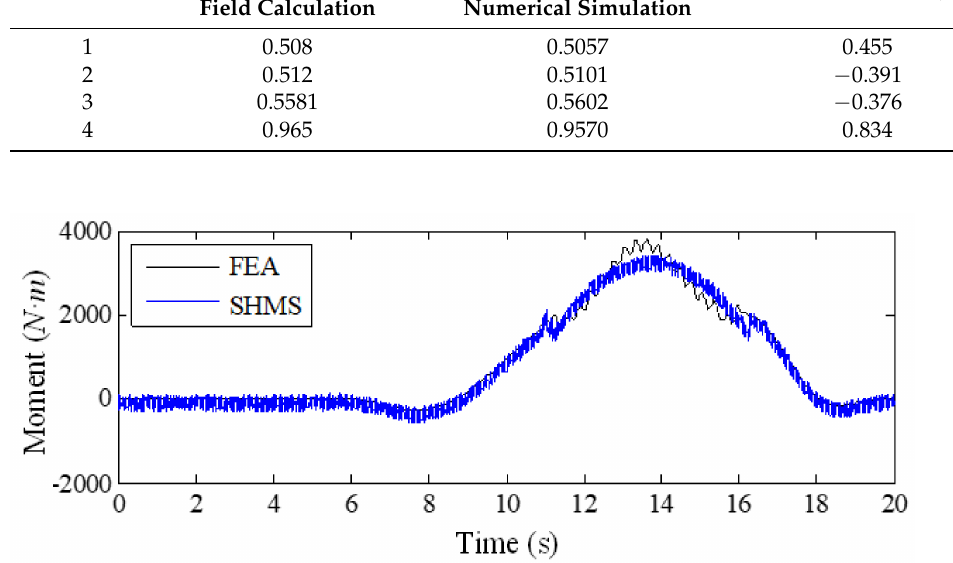
Figure 5. Monitoring and numerical curves of bending